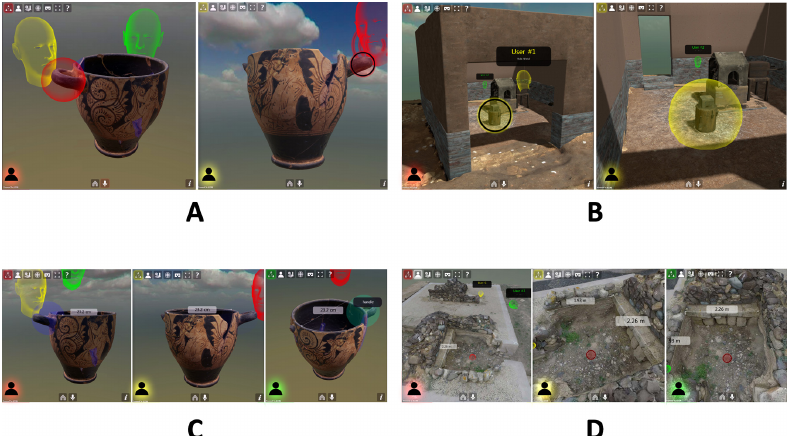
Figure 15. Sample collaborative sessions in Hathor with 3 users (red, yellow and green). ( A ) User 0 (red, left view) is streaming its focus to other participants, right is yellow user view. ( B ) User 1 (yellow) is streaming its focus, and changed lighting settings at runtime (red view left, yellow view right). ( C , D ) All three users perform annotations and measurement tasks at different